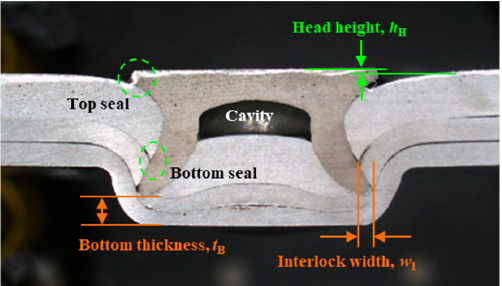
Figure 3. The de fi nition of geometrical indexes of an SPR joint.